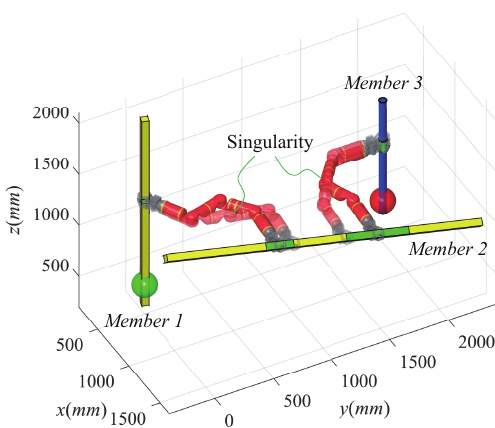
Figure 12. The comparison of determination of transition grips with and without consideration of the grip manipulability.